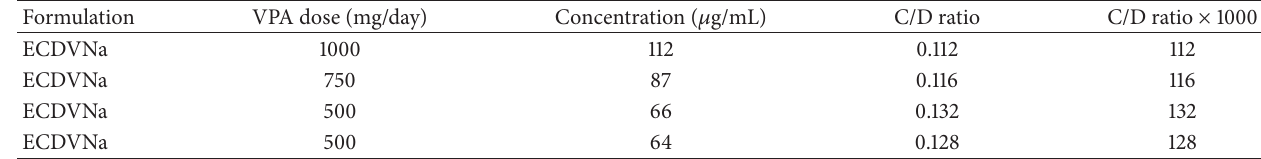
Table 1: Explaining VPA C/D ratio use with VPA concentrations from a published case